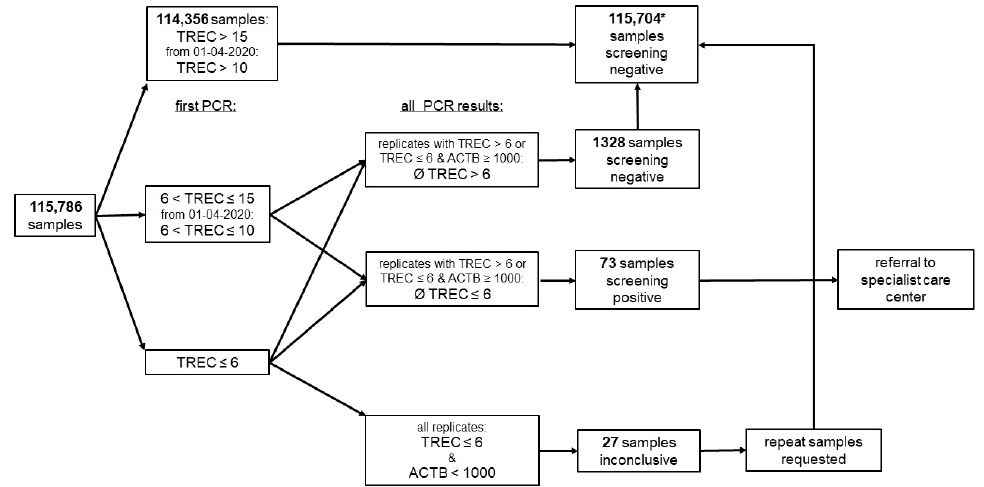
Figure 1. Screening algorithm. Analyte concentrations are reported in copies/well, and the referral cut-off was TREC ≤ 6 copies/well; * 2 parents refused newborn screening but sent screening cards to the laboratory, 7 children with inconclusive samples were lost to follow-up, and 20 had normal values upon testing of a new screening card.